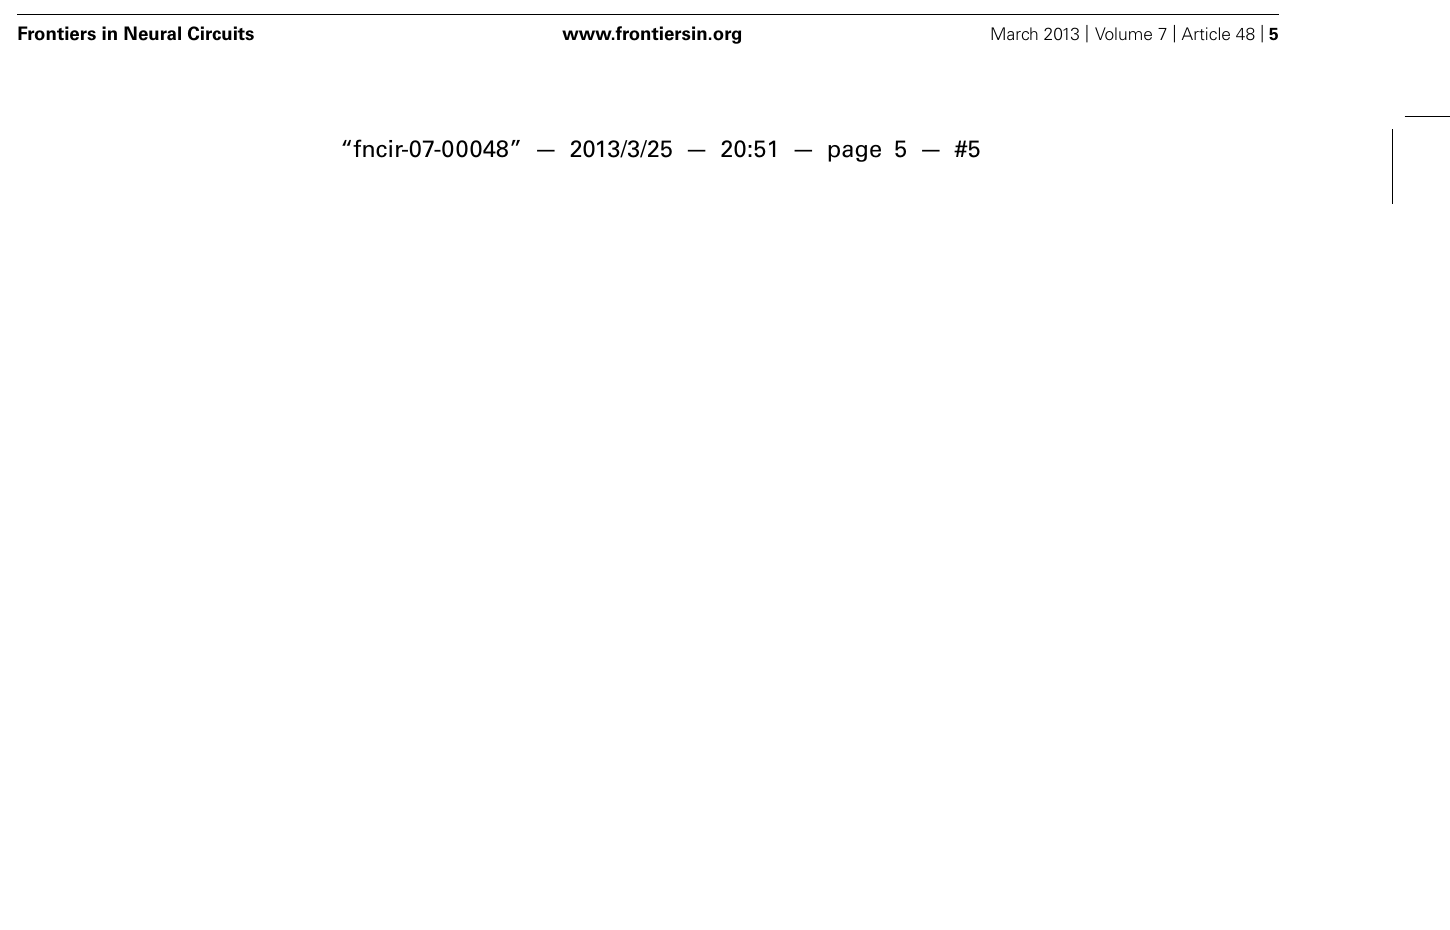
SI obs (E) , where A P1e is the peak amplitude of the P1 component at electrode e, L P1e the peak latency of the P1 at the same electrode, and N the number of electrodes. For the bootstrap, the P1 latency values of the original map were randomly shuffled in space to create a “random P1 latency map” (C) .We calculated the SI between this “random latency map” and the original P1 amplitude map, SI rand (F) .This procedure was repeated 1000 times to build a distribution of SI rand (D) . SI obs was compared to the distribution of SI rand to assess if the similarity between the two observed maps was